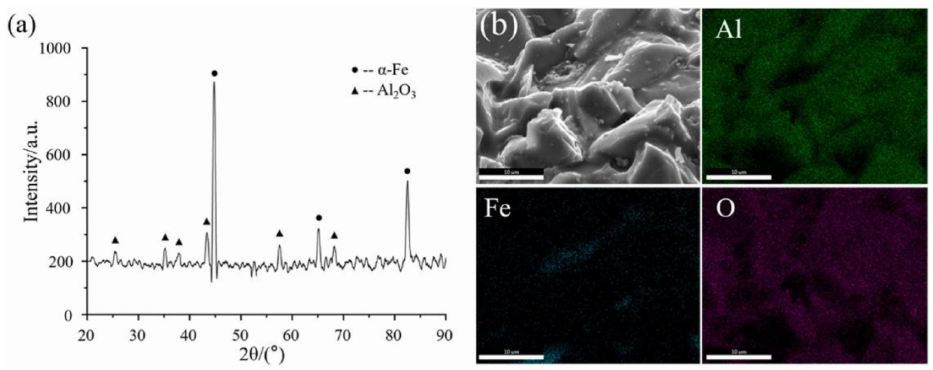
Figure 7. XRD graph ( a ) and EDS surface scan ( b ) of Al 2 O 3 magnetic abrasive